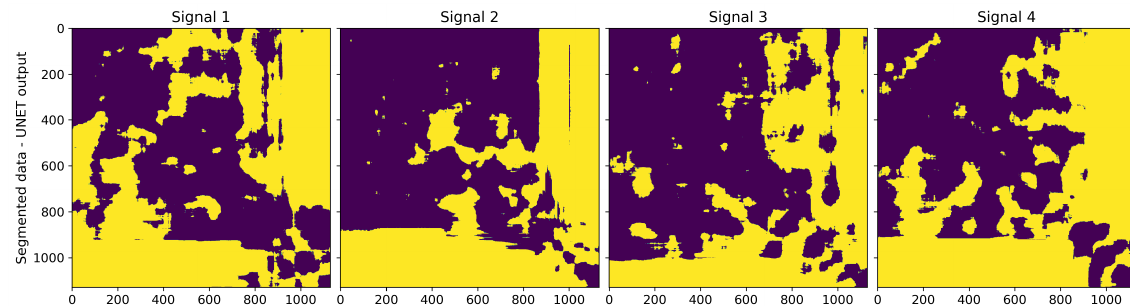
Figure 8. Segmented {G 1 , G 2 , G 3 , G 4 } after U-NET inference